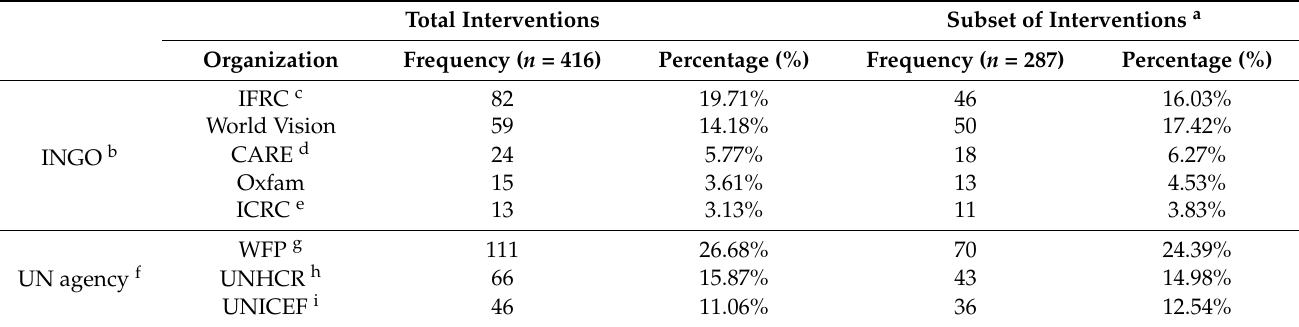
a Represents a subset of interventions for which a greater level of detail was available (contained information (i.e., not “undefined”) for at least two of the following categories: intended beneficiaries; the aspect(s) of COVID-19 addressed by the intervention; and local INGO = international non-governmental organization. c IFRC = International Federation of Red Cross and Red Crescent Societies. d CARE = Cooperative for Assistance and Relief Everywhere. e ICRC = International Committee of the Red Cross. f UN Agency =